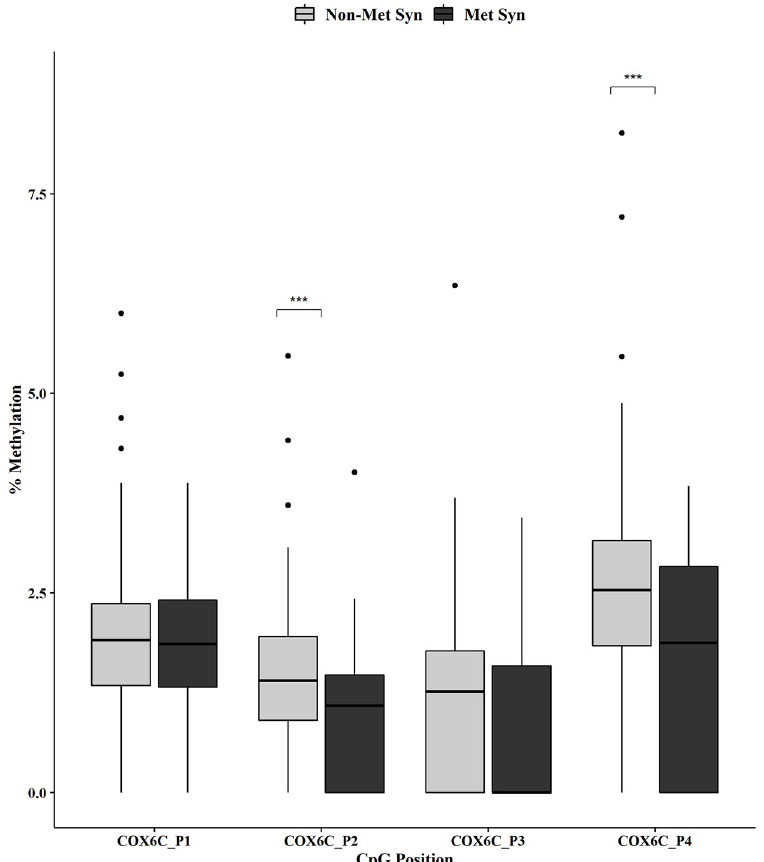
Fig 2. COX6C promoter DNA methylation by MetS status. DNA methylation at four CpGs within the promoter of COX6C was measured in non-MetS (n = 110) and MetS (n = 74). Mann-Whitney U test was used for the statistical comparisons between the non-MetS versus MetS. ��� p <